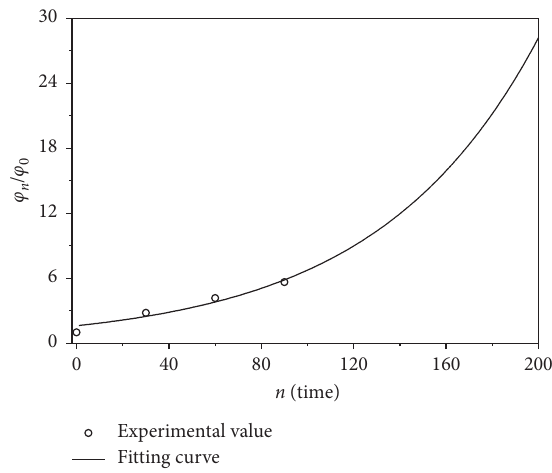
) varying with number of freeze-thaw cycles ( n n / ϕ 0